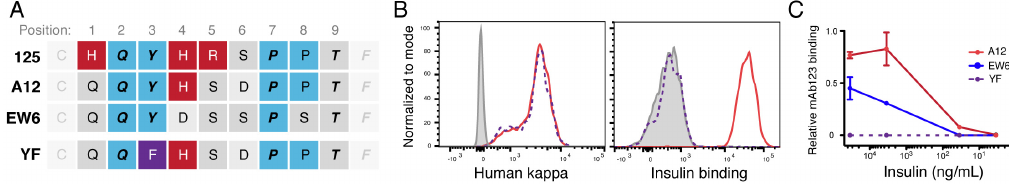
Figure 3. Light-chain CDR3 tyrosine is required for insulin binding by VH125 family antibodies. ( A ) Alignment of CDR3 regions of VL genes from framework region cysteine at position 0, highlighting positive-charged residues (red), conserved residues among these CDR3s (bold-italics), and the QYxxxPP motif (blue); ( B ) retroviral light-chain expression on VH125, GFP+, IgM+ cells transduced with A12 (red), YF (purple dashed), or non-transduced GFP- (gray-filled) (left). Binding to labeled insulin by A12 compared to YF mutant and non-transduced GFP- (right). ( C ) Detection of receptor occupancy at multiple concentrations of unlabeled insulin using mAb123 normalized to IgM level. Shown are data representative of at least three experiments.